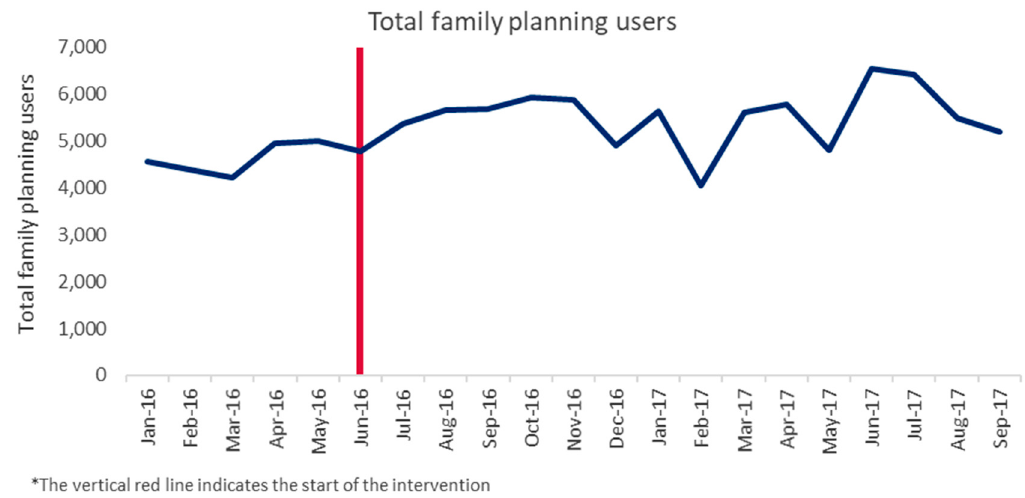
Figure 2. Total family planning users at implementation sites in Dowa, pre- and postimplementation.